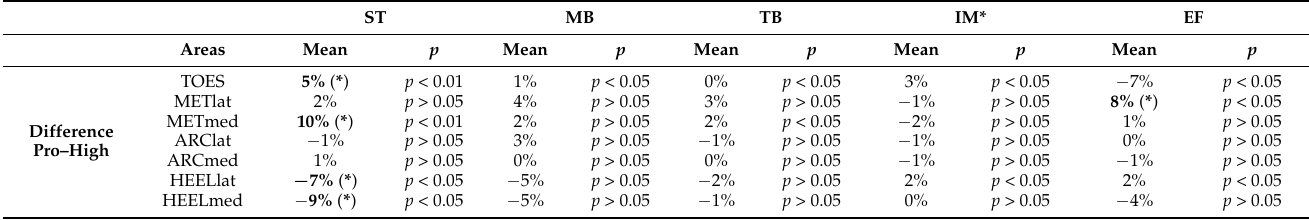
Table 3. Differences in the means of the normalized pressures in the right foot (rear) between Profes- sionals and High handicap players (Difference Pro–High) and Professionals versus Medium handicap players (Difference Pro–Medium) at the key time instants (ST (Stand), MB (middle backswing), TB (top backswing), IM (Impact), EF (early finish)) in the seven previously defined areas (Toes (all toes), METlat (lateral metatarsal), METmed (medial metatarsal), ARClat (lateral arch), ARCmed (medial arch) HEELlat (lateral heel), HEELmed (medial heel)). The * denotes a statistically significant difference between the compared groups (Professional vs. high or Professional vs. Medium) with significance level p <